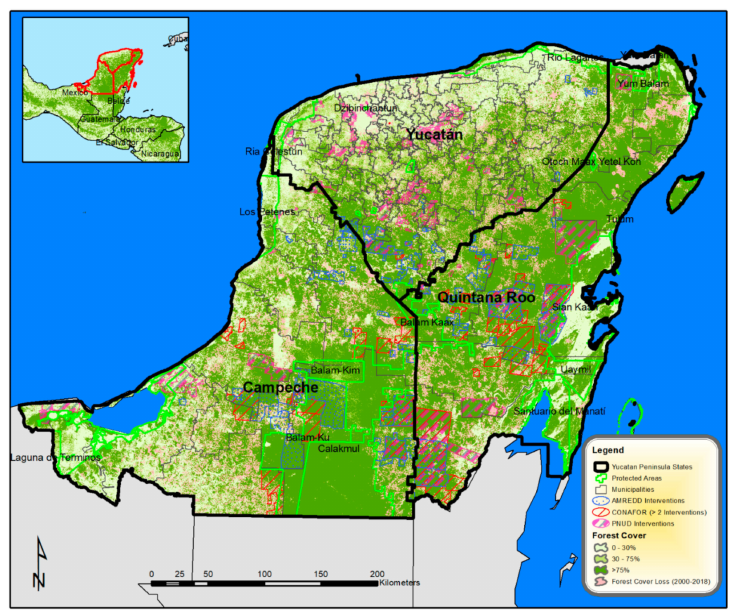
Figure 1. Yucatan Peninsula study area showing 2010 forest cover [45], deforestation (2000–2018) [38], municipalities, and REDD + (Reducing Emissions from Deforestation and Degradation)-intervened community territories